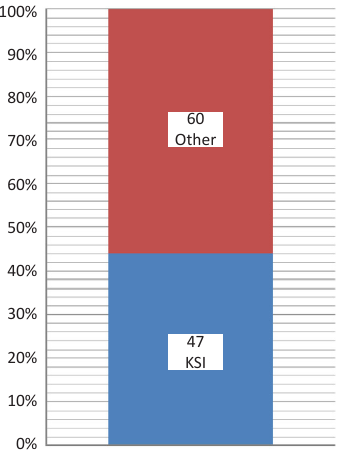
Figure 1. Reasons for encounter